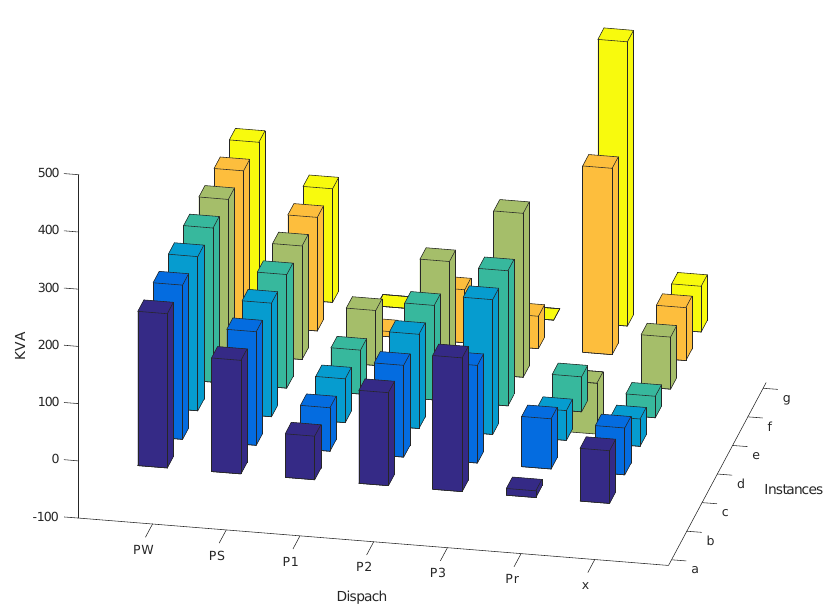
Figure 4. Behavior of the dispatch in the cases analyzed.